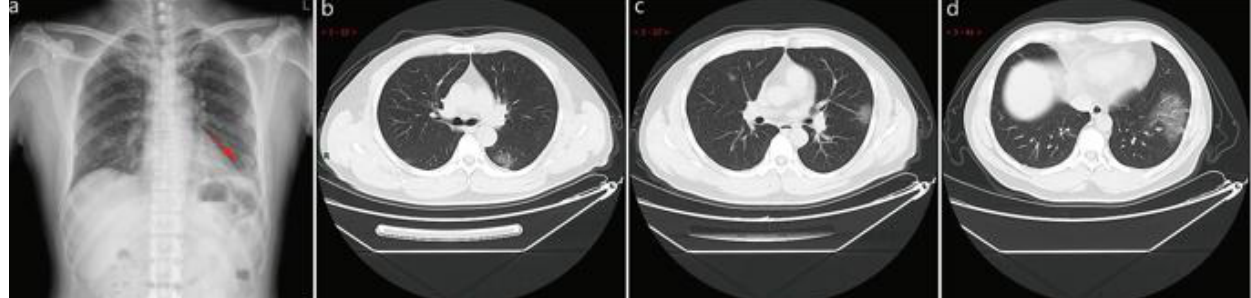
Figure 2: Typical CT / X-ray imaging manifestation (case 2). A 51 years old male with general muscle ache and fatigue for 1 week, fever for 1 day (39.1 ℃), anemia. Laboratory test: normal white blood cells (9.24 × 10 9 /L), lymphocytes percentage (5.1%), decreased lymphocytes (0.47 × 10 9 / L), decreased eosinophil count (0 × 10 9 /L), increased C-reaction protein (170.91 mg/L), increased procalcitonin (0.45 ng/ml), increased erythrocyte sedimentation rate (48 mm/h). Imaging examination: a shows patchy shadows in the outer region of the left lower lobe, b shows large ground-glass opacity in the left lower lobe, and c shows subpleural patchy ground-glass opacity in posterior part of right upper lobe and lower tongue of left upper lobe, d shows large ground-glass. opacity in the basal segment of the left lower lobe